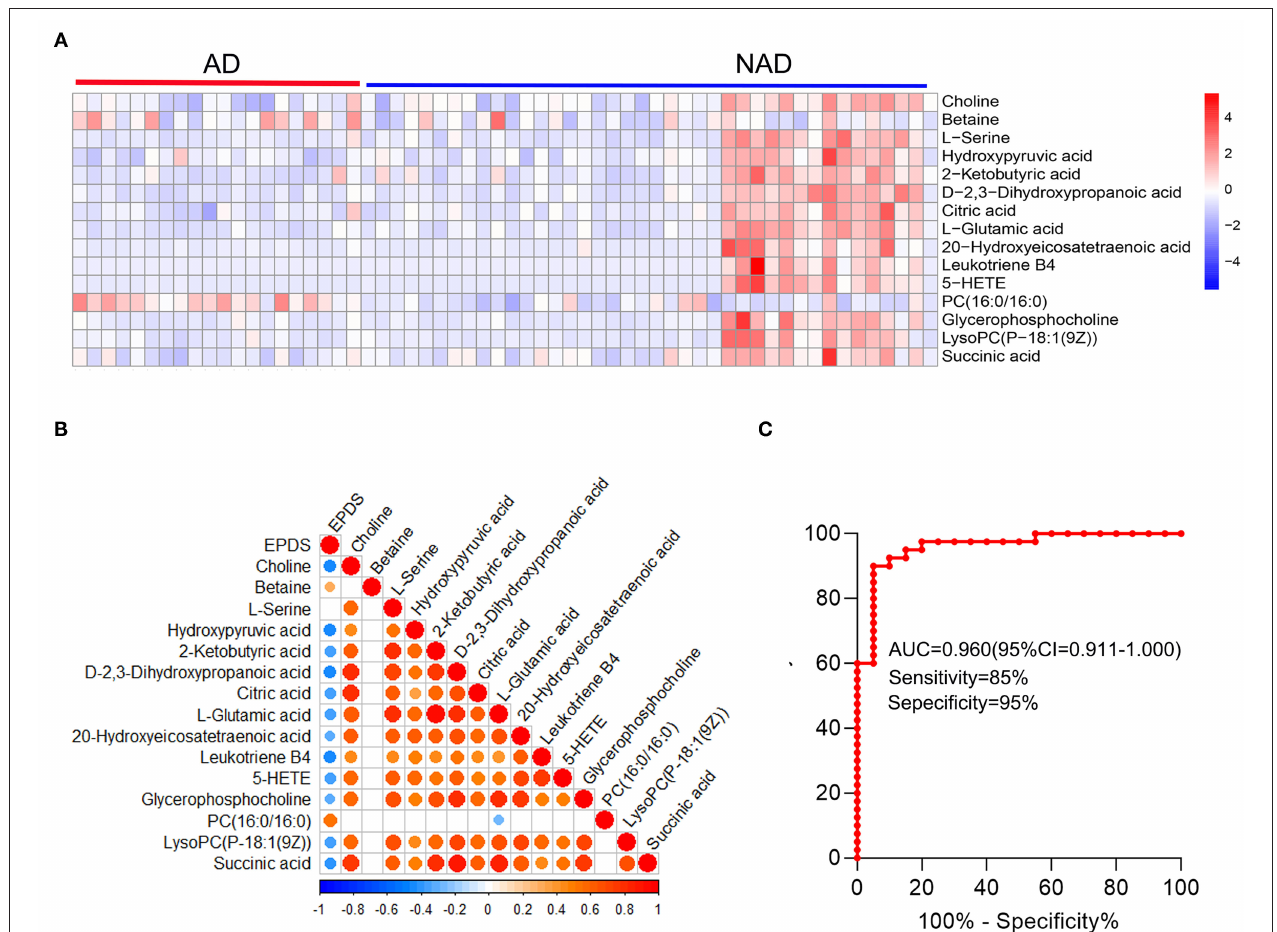
FIGURE 4 | Systems analysis of key differential metabolites. The heatmap visualization of key differential metabolites from the differential pathway (A) , Spearman’s correlation was conducted between key differential metabolites and EPDS (B) , and ROC curve (C) of the whole differential metabolites. A significant ( p < 0.05) positive and negative correlation is indicated with a red and blue color, whereas a non-significant correlation is indicated with blank. EPDS, Edinburgh Postnatal Depression